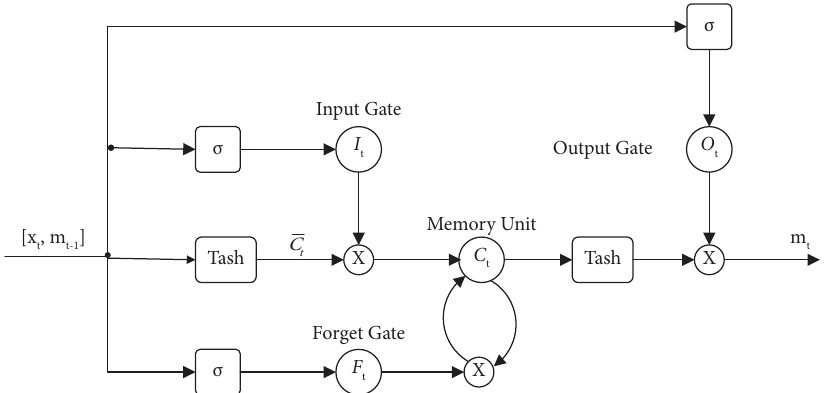
Figure 2: Time series prediction data set transformation.